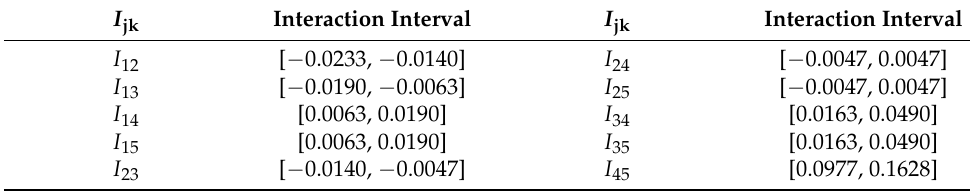
Table 7. Interaction